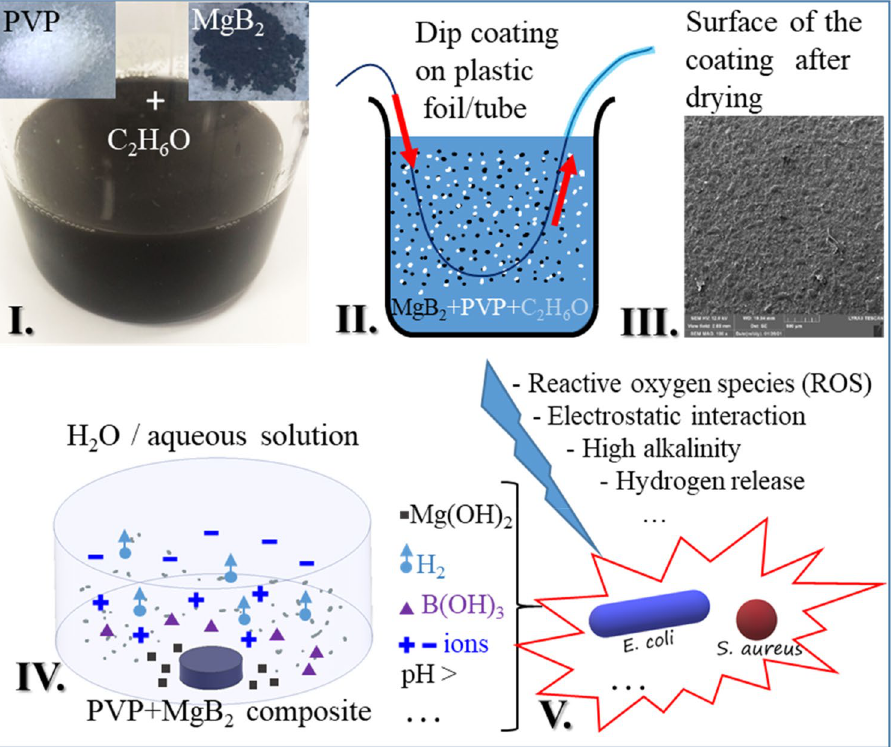
Figure 2. Preparation of composite MgB 2 -PVP coatings ( I – III ), release of active MgB 2 from the composite coating and its decomposition in the presence of water/aqueous solution ( IV ), and the antimicrobial effect through possible mechanisms on different microbes. SEM image from III is taken on the sample (MgB 2 - PVP) foil 0.25